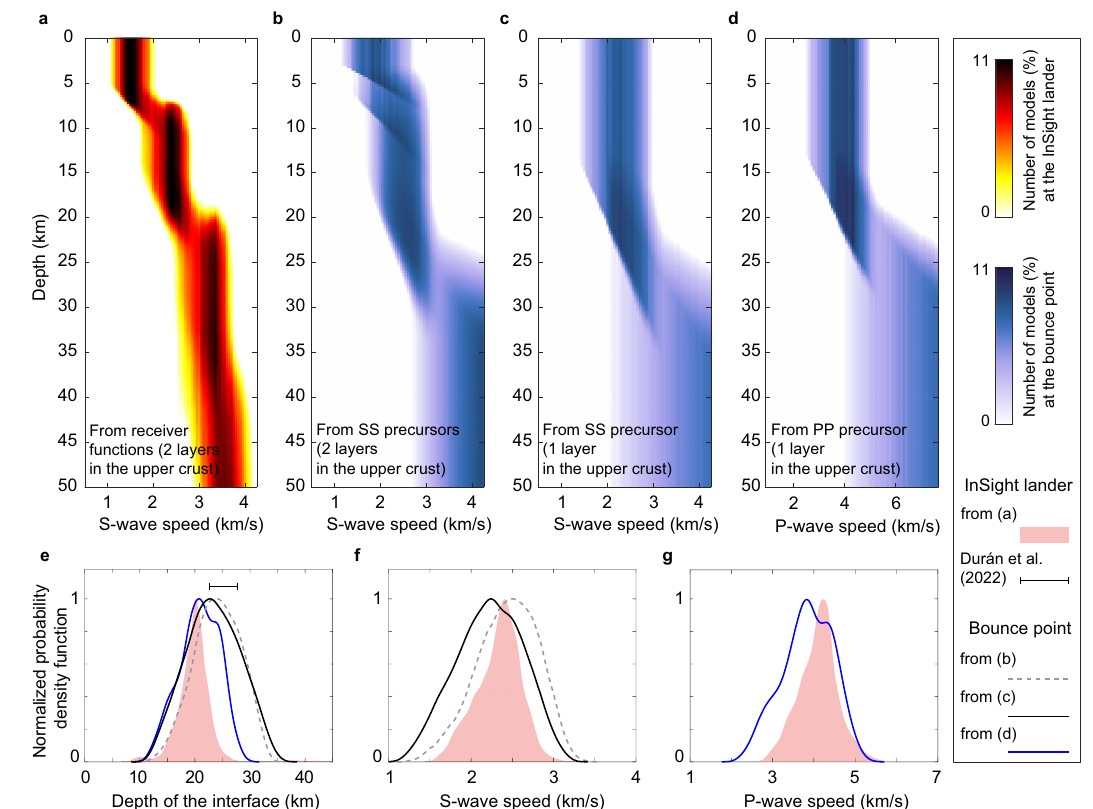
Fig. 4 | Seismic velocity pro fi les from the inversion. a The three-layer crustal models beneath the InSight landing site from the receiver function study 11 , with an intra-crustalinterfaceat20±5km.Thecolorscaleindicatesthenumberofmodels. b Inverted S-wave speed models at the bounce point with two layers in the upper crustfromthe SSprecursorsinthisstudy. c Similarto( b ),butwithone layerinthe upper crust. d Similar to ( c ), but for the P-wave speed with one layer in the upper crust. e Normalized probability density functions for the depth of the intra-crustal